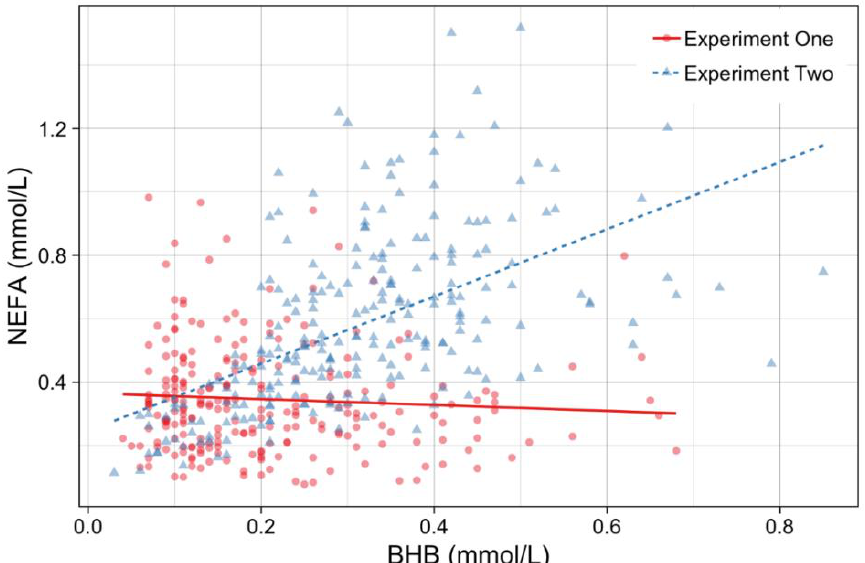
Figure 4. The relationship between non-esterified fatty acids NEFA (non-esterified fatty acid) & βHB (β-hydroxybutyrate). Red dots represent Experiment One cattle. Blue triangles represent Experiment Two cattle. The lines are fitted linear regression lines for the two groups.